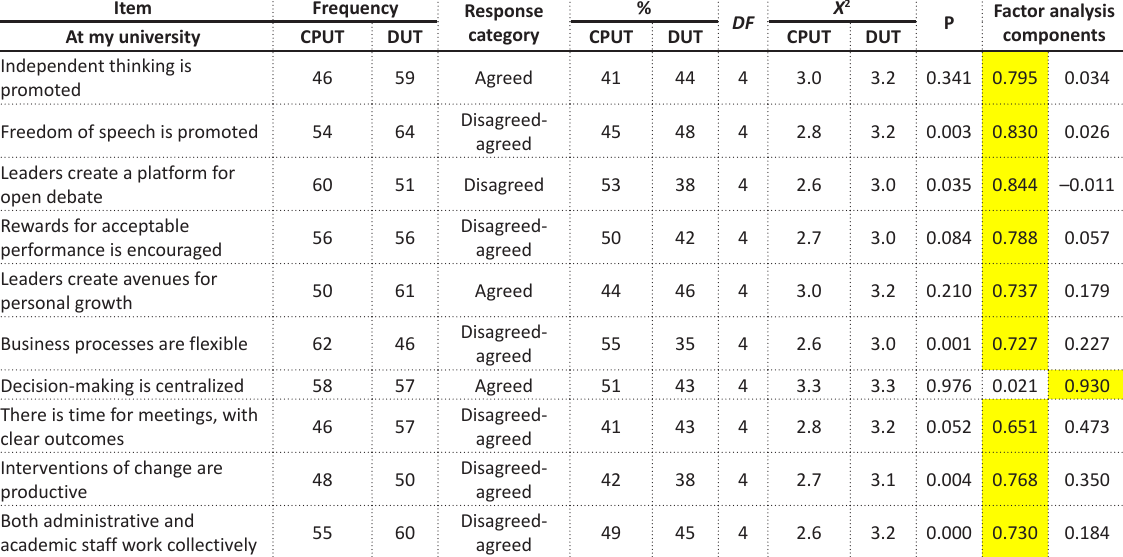
Table 5. Cognitive capabilities of leadership